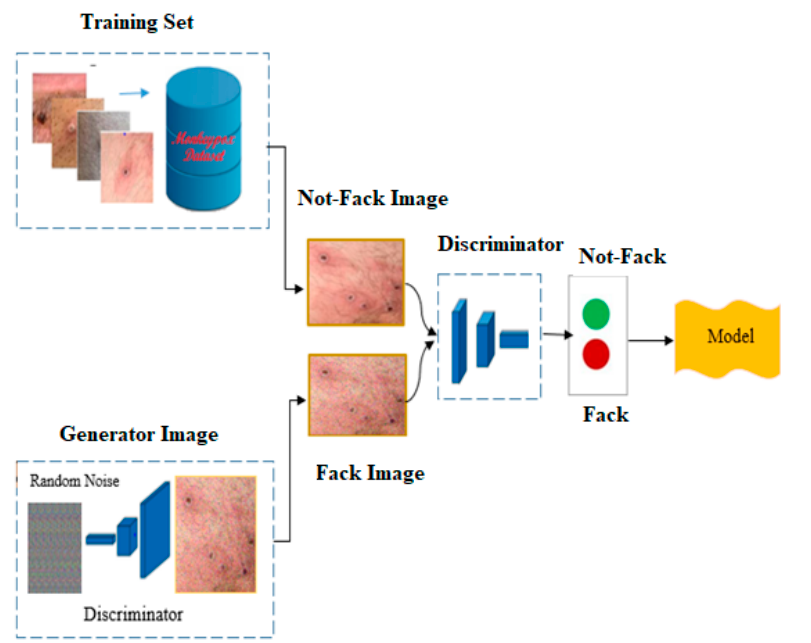
Figure 3. AGN network model. Table 2. Distribution of our original and augmented data.